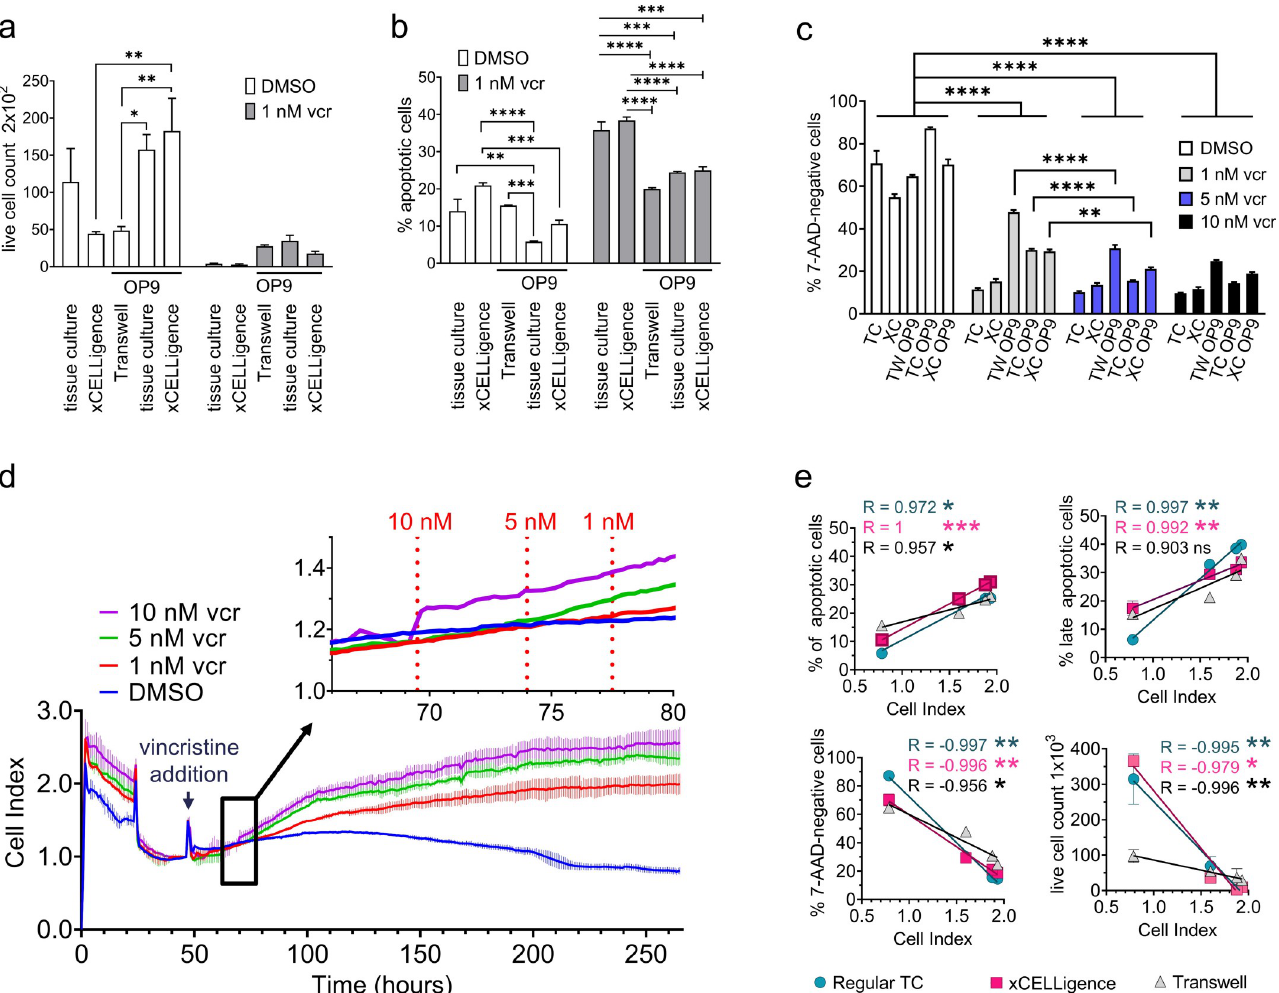
Fig 5. Comparison of end-point tissue culture with OP9 displacement. US7 cells were plated on 96-well tissue culture plates (TC = tissue culture), HTS 96 well Transwell plates (TW = transwell), and E-Plate 16 devices (XC = xCELLigence) as indicted in the figure (all coated with fibronectin) and exposed to either DMSO or 1 nM vincristine (vcr). On day 9, cells were harvested and examined for (A) live cell numbers using Trypan blue exclusion (B) apoptotic cells by FACS using 7-AAD and Annexin V (C) living cell percentages based on FACS and negativity for 7-AAD. Statistical analysis was done using two-way ANOVA, followed by Bonferroni posttests. Error bars represent standard deviation. p values: � < 0.05, �� < 0.01; ��� < 0.001; ���� < 0.0001. (D) xCELLigence continuous monitoring of parallel cultures under the indicated drug treatments (n = 3). Dotted lines in inset indicate time points of early differentiation visible between the controls and treatment wells. (E) Correlation of cell index values with conventional cell viability measurements. Error bars represent standard deviation. p values of correlation coefficient: � < 0.05, �� < 0.01; ��� < 0.001.